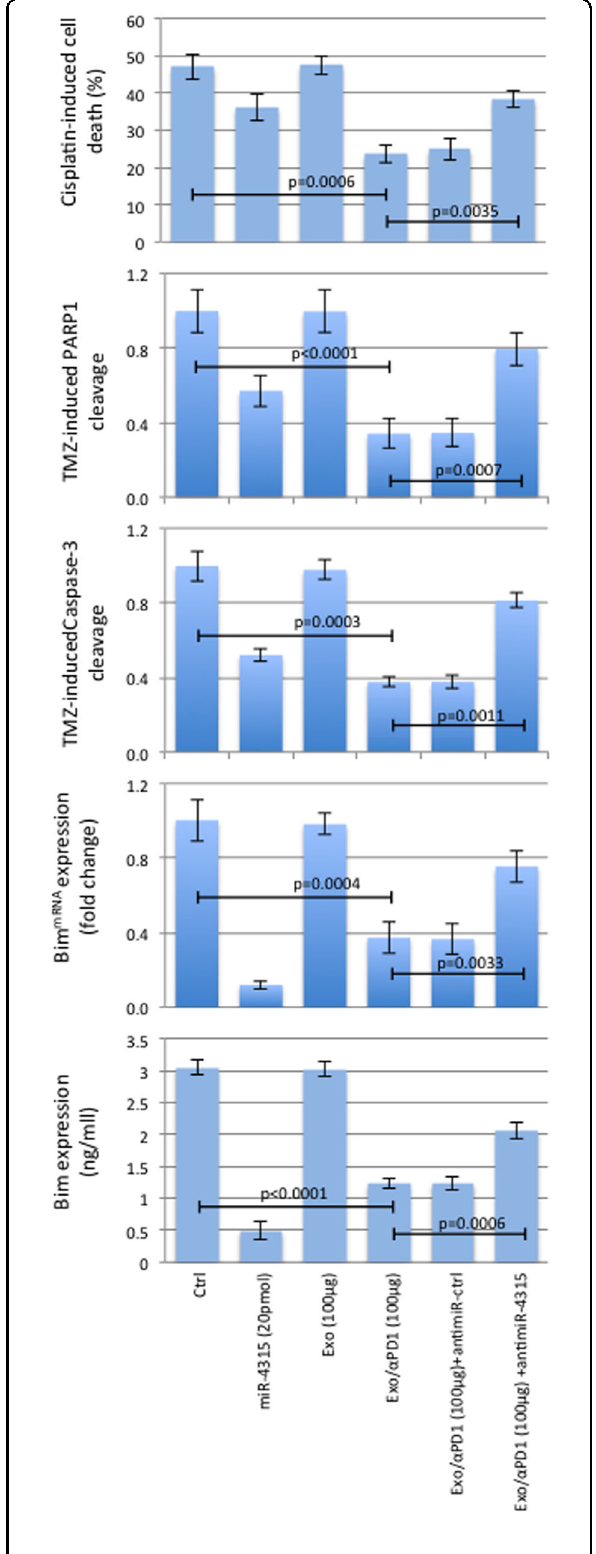
Fig. 3 Exosomes derived from T cells exposed to α PD1 (Exo/ α PD1) promote a phenotype of cisplatin-induced apoptosis in A549 cells via miR-4315. Cisplatin-induced cell death measure, PARP and Caspase-3 cleavages were applied to show that exosomes derived from T cells exposed to α PD1 (Exo/ α PD1) promote a phenotype of cisplatin-induced apoptosis. RT-qPCR and in-cell ELIZA were applied to show that this phenomenon is associated with the miR-4315-mediated down-regulation of